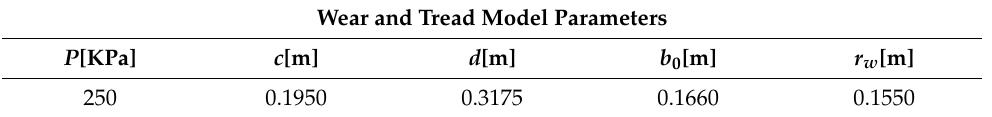
Table 3. Wear and tread model